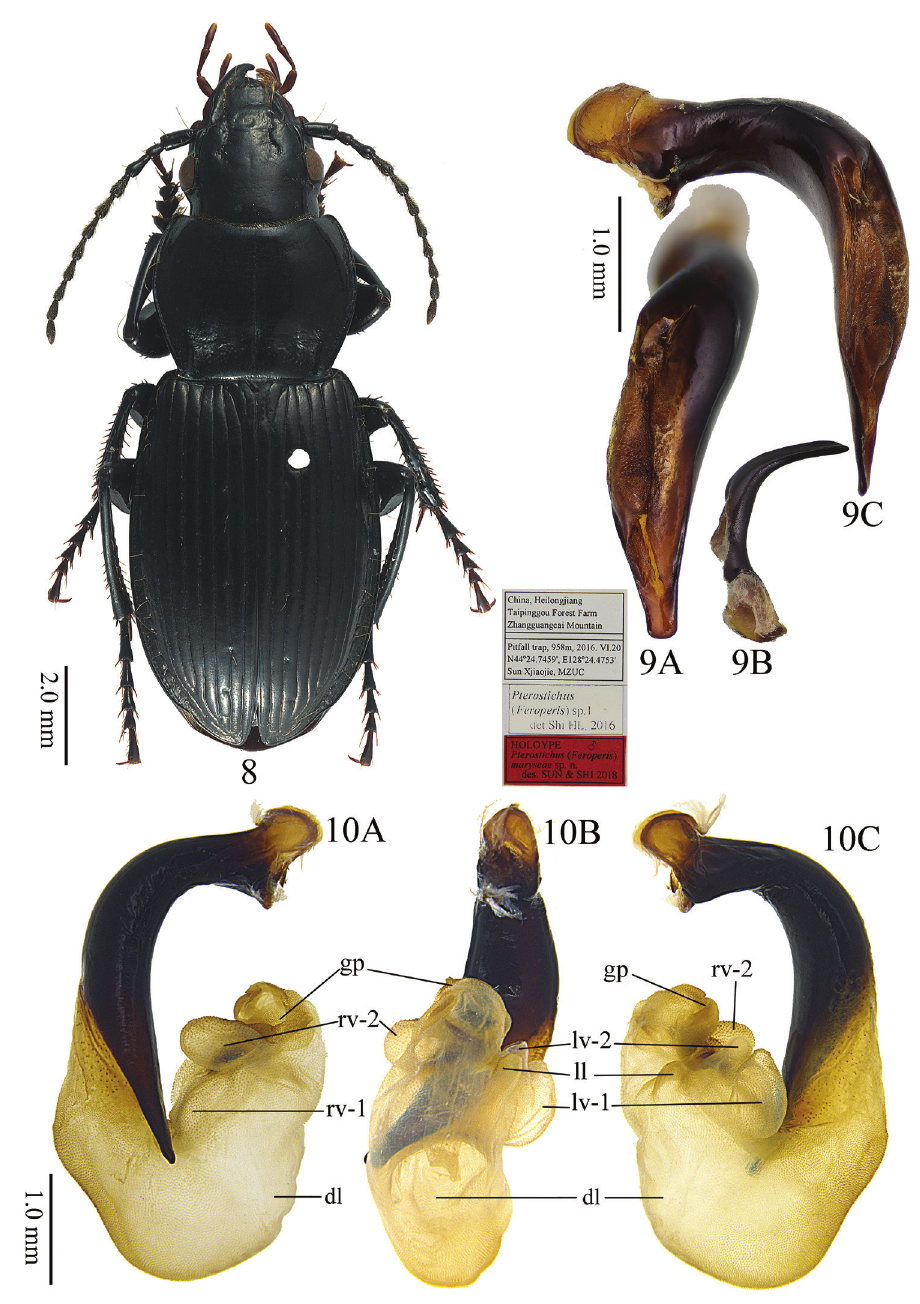
A dorsal view of median lobe, B right paramere, C left lateral view of median lobe 10 Endophallus of a paratype A right lateral view, B ventral view, C left lateral